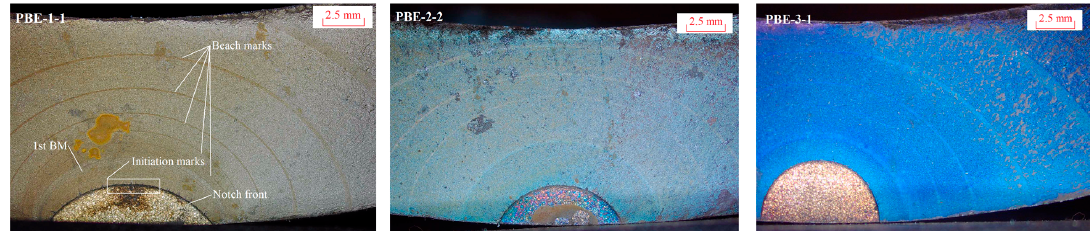
Figure 5. Notch type: ( a ) semi-elliptical notch; ( b ) rectangular notch [23], and ( c ) notch with a straight bottom [25].